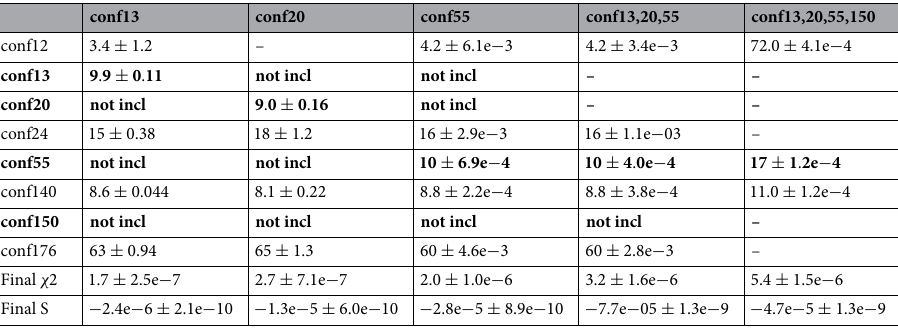
Table 2. Populations of conformations determined using BioEn 0.1.1 37 on the 73 P1LnkP2 conformations for which the distance between the geometric centers of P1 and P2 was larger than 32 Å and various closed conformations among 13, 20, 55 and 150, previously selected according to the fit of PRE data (Fig. 2). After ten runs starting from random values of populations and performed on the whole set of conformations, all conformations for which the sum of populations over the ten runs was larger than 0.01 were gathered, and a second run of ten additional BioEn calculations was performed on this reduced set of conformations. The average and standard deviation values of populations obtained for each selected conformation from the 2 second set of BioEn runs, are given in the Table, along with the final average values of χ and of entropy S . In each calculation, the conformations tagged as “not incl” have not been initially included in the calculation, whereas the conformations tagged as “–” were included in the calculation, but not selected by BioEn 37 . The conformations belonging to the set of closed conformations are written in